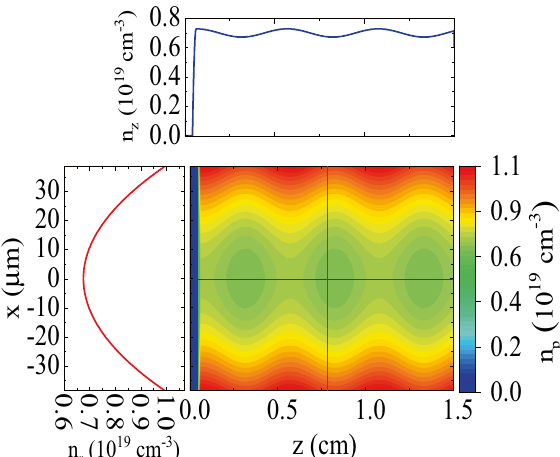
Figure 1. Heatmap showing the plasma density of the corrugated plasma channel. The curve at the top (blue) and the curve on the left (red) are its horizontal on-axis and vertical line-outs, respectively.